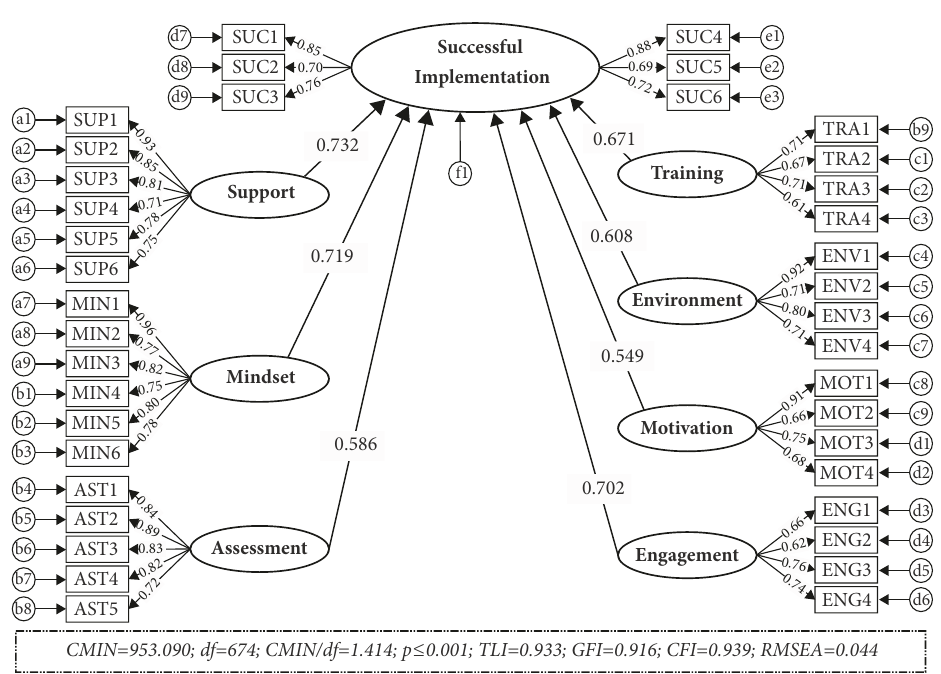
Figure 3: Standardized SEM model of successful Kaizen